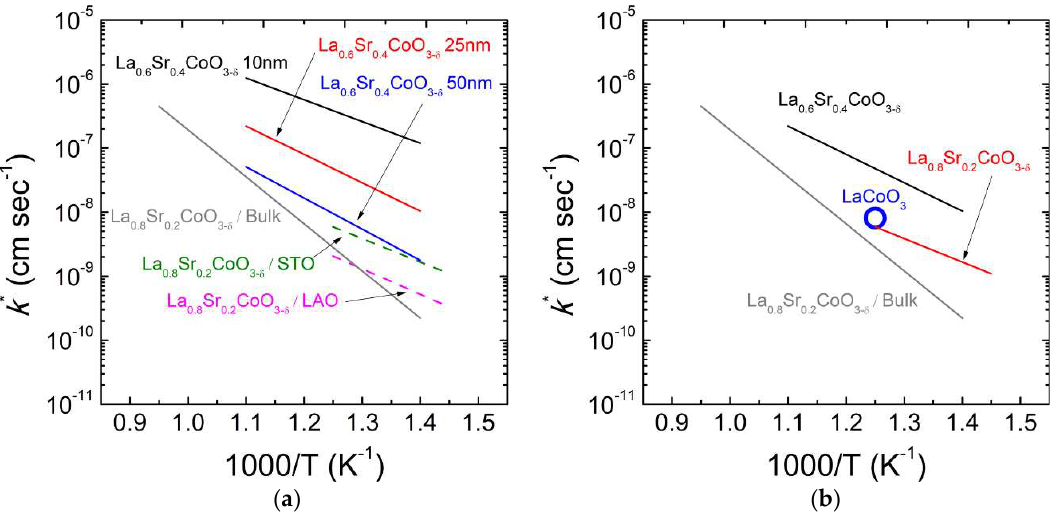
Figure 3. Arrhenius plots of surface exchange coefficients ( k *) for epitaxial La 1-x Sr x CoO 3-δ thin films. ( a ) Effect of thickness difference on k * for La 0.6 Sr 0.4 CoO 3-δ [96] and of substrate difference (STO and LAO) on k * for La 0.8 Sr 0.2 CoO 3-δ [64] thin films and La 0.8 Sr 0.2 CoO 3-δ [9] polycrystalline samples. ( b ) Effect of Sr substitution on k * for La 1-x Sr x CoO 3-δ (x=0, 0.2 and 0.4, [64,95,96]) thin films and La 0.8 Sr 0.2 CoO 3-δ [9] polycrystalline oxides.